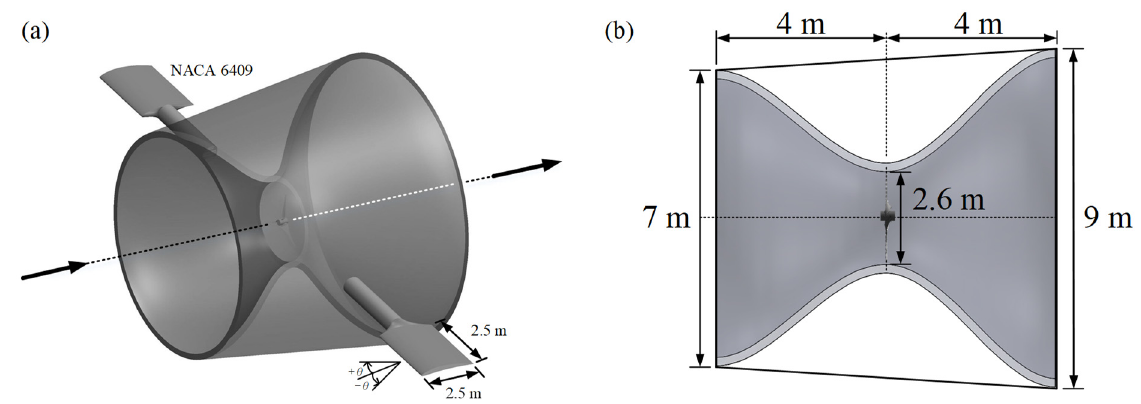
Figure 4. ( a ) Three-dimensional diagram and ( b ) plan view of the duct used in the simulations.